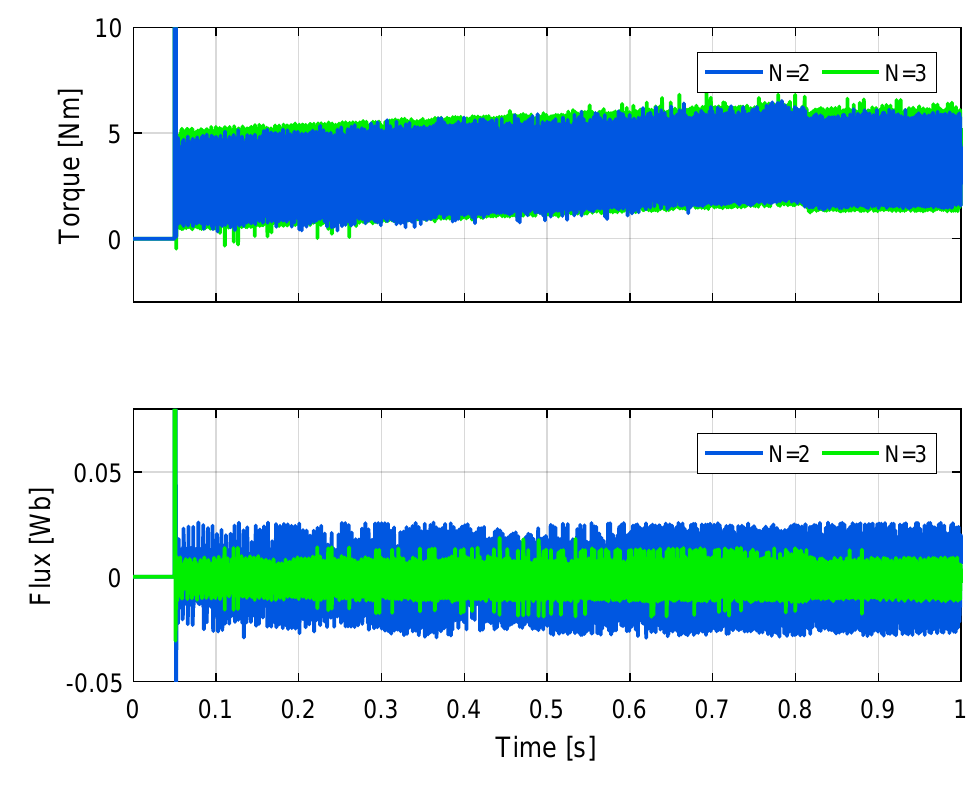
Figure 14. Comparison of N values for